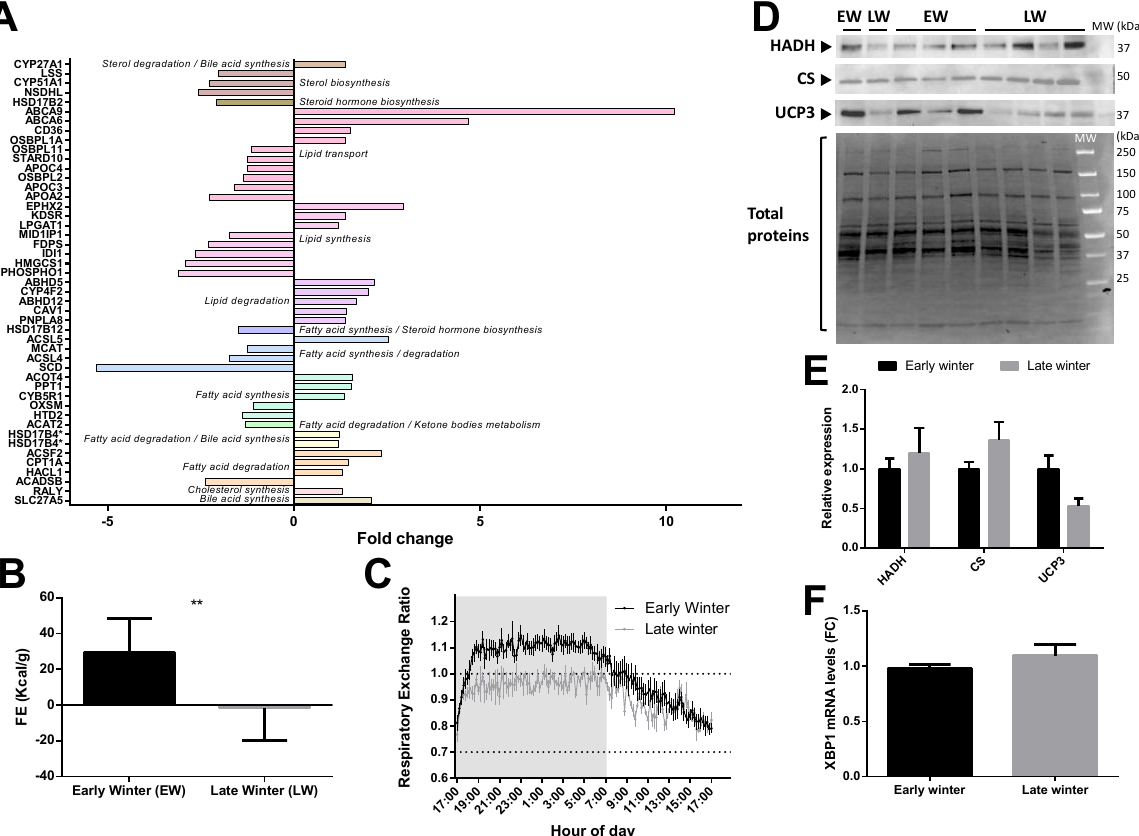
Figure 4. Regulation of liver lipid metabolism in grey mouse lemurs during winter. The relative abundance of liver proteins involved in carbohydrate metabolism in early (EW) and late (LW) winter mouse lemurs (N = 5/group) is shown using mean fold changes in LW vs EW (panel A ; presence of several isoforms of the same protein are indicated with asterisks (*). Food efficiency (FE), calculated as the ratio between food intake (in Kcal/day) and BMC were significantly different between EW and LW animals (panel B ), and the respiratory exchange ratio measured in EW (black line) vs. LW (grey line) reflected the main energy substrates used, depending on time-of-day (panel C ). Protein expression levels of mitochondrial hydroxyacyl-coenzyme A dehydrogenase (HADH), citrate synthase (CS) and uncoupling protein 3 (UCP3) were measured using Western-blot analysis in liver samples from mouse lemurs in EW and LW (blots shown in panel D and relative expression in (panel E ); N = 4–5/group; results are presented as the means ± SEM). XBP1 gene expression levels did not differ in the liver of adult male mouse lemurs between EW and LW (panel F ). * and ** indicate significance at p < 0.05 and 0.01 between EW and LW,